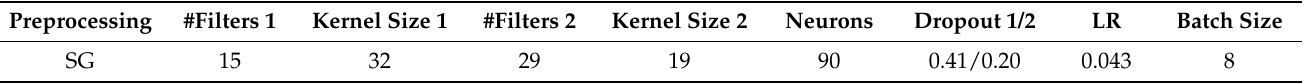
Table 6. Optimized hyperparameters of 1D CNN for training process with samples of TF from 2012 until 2017 using BOGP. Preprocessing #Filters